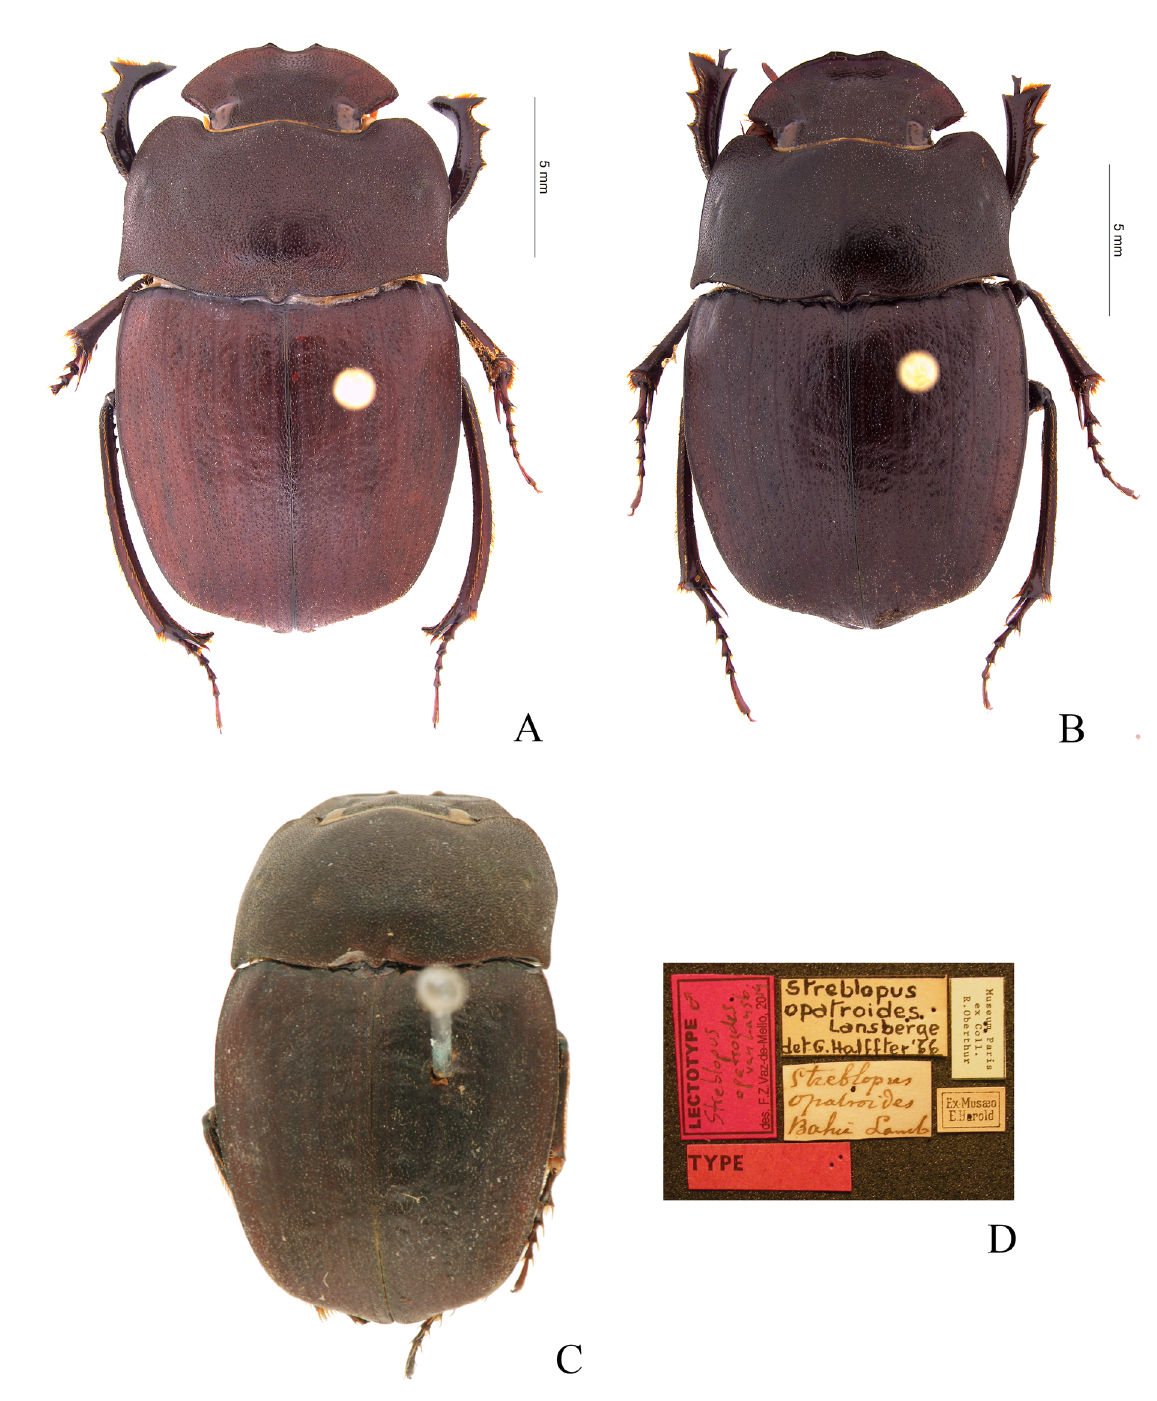
Fig. 1. Streblopus opatroides van Lansberge, 1874. A‒B . Ordinary specimens, dorsal view. A . ♂. B . ♀. C‒D . Lectotype, ♂. C . Dorsal view. D . Attached